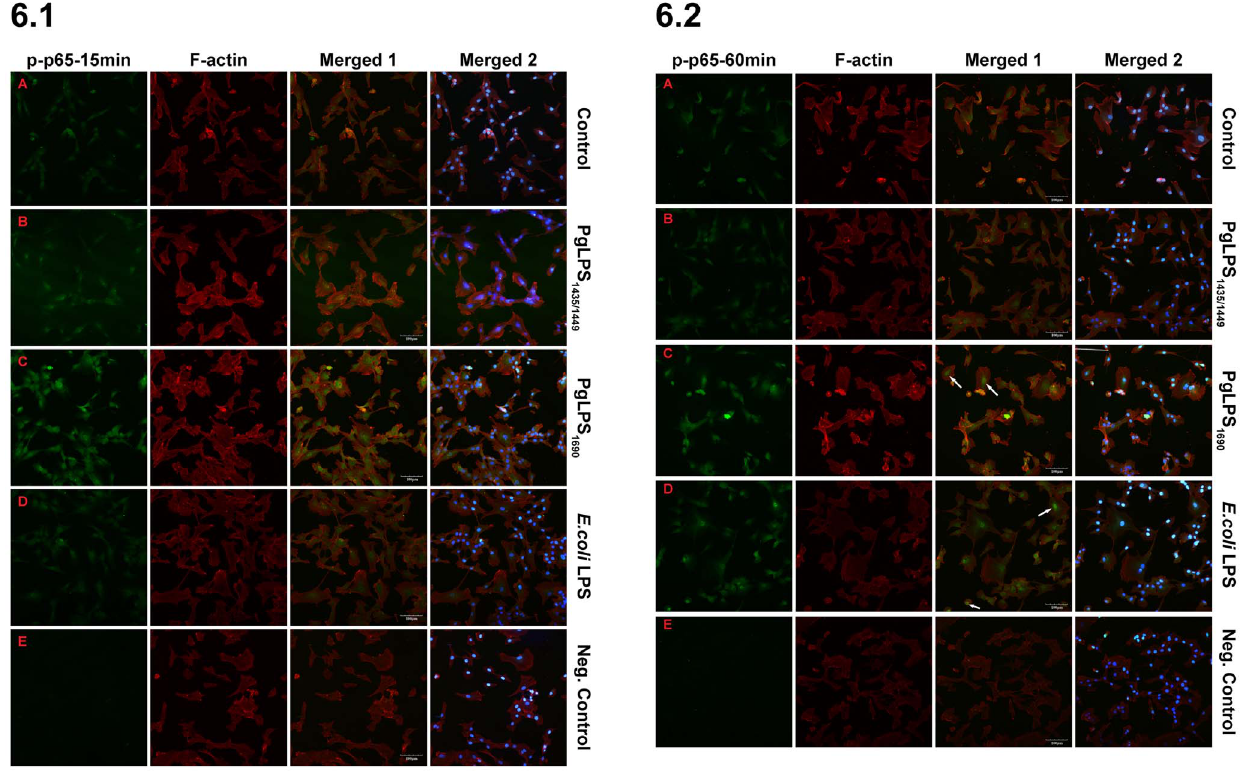
Figure 6. Confocal images of p-p65 NF- k B nuclear translocation in LPS treated HGFs. The cells were left untreated (A) or stimulated with P. gingivalis (Pg) LPS 1435/1449 ( PgLPS 1435/1449 ) (B), PgLPS 1690 (C) and E. coli LPS (D) (1 m g/ml) for 15 min ( 6.1 ) and 60 min ( 6.2 ), respectively. Cells were permeabilized with 0.1% Triton X-100 and subsequently stained with primary antibodies against anti-phospho p65-NF- k B and the correspondent secondary antibody labeled Alexa fluor 488 anti-rabbit, and subsequently stained with alexa fluor 555 phalloidin for F-Actin. The cytoplasmic p-p65 NF- k B appears in green color and F-actin is shown in red color. Negative control: E. The arrow heads show the prominent nuclear staining in the nucleus. Merged 1 images present the combined p-p65- NF- k B and F-actin, whereas Merged 2 images show the combined p-p65-NF- k B, F-actin and nuclear staining which is counterstained with DAPI. The experiment was performed three times, and the pictures observed correspond to a representative field for each of the times studied. Scale bar=100 um.